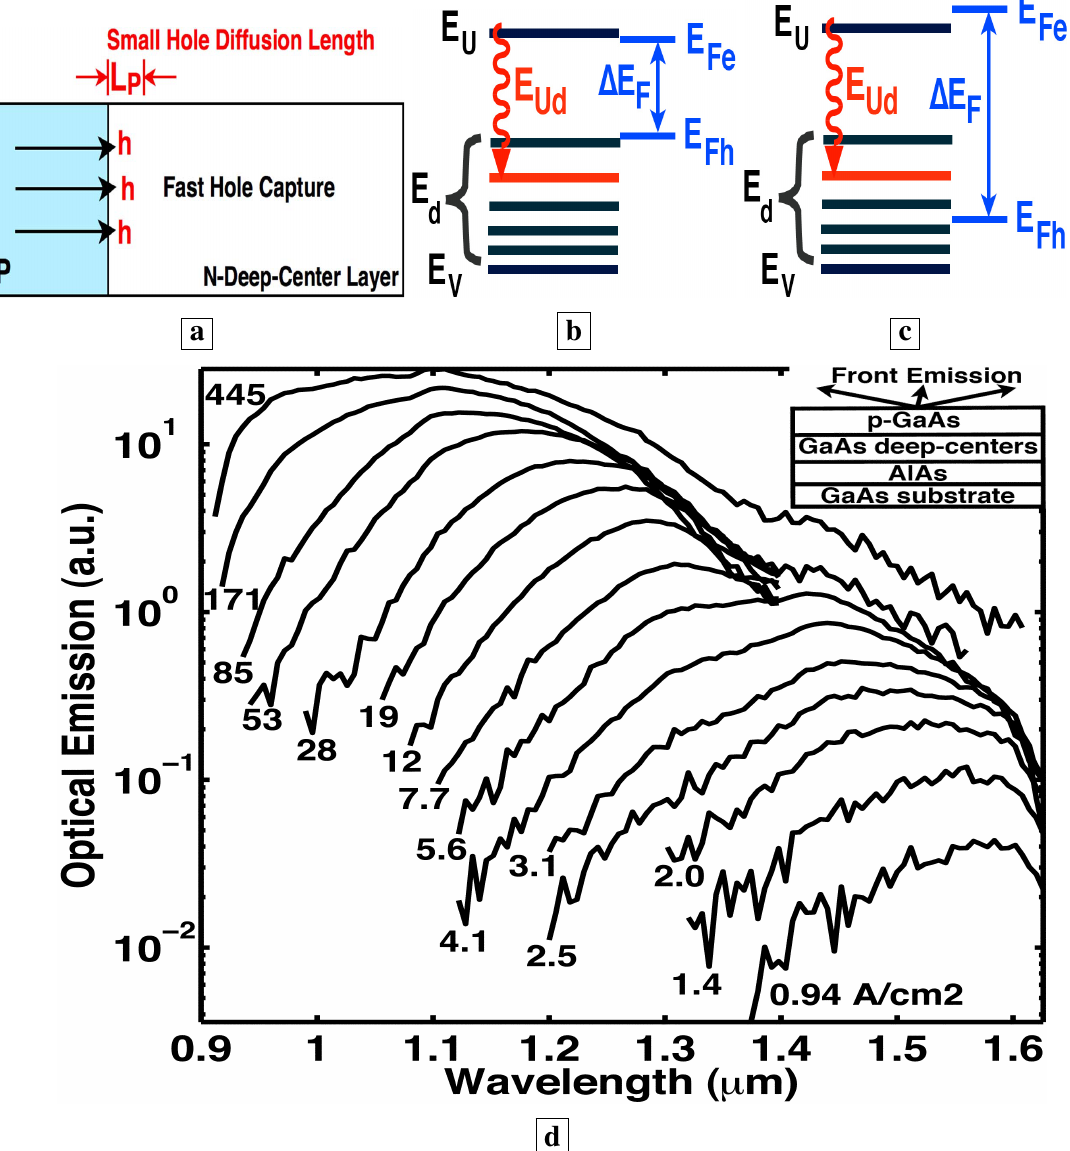
Figure 13 . Room-temperature spectra measured from the surface of Sample F [6]. a, Layer structure showing p-doped layer, n-type deep-center layer, and hole diffusion length. b, At low current, the hole quasi-Fermi level E is above midgap, and most of the optical Fh emission is at long wavelengths (1.6 µ m). At high current, E is pulled far below midgap, Fh and most of the optical emission is at shorter wavelengths (1.1 µ m). Here, ∆ E exceeds F the transition energy E . This is the Bernard-Duraffourg signature for stimulated emission Ud at E . d, Room-temperature optical-emission spectra measured from the sample surface at Ud different injection in the absence of a resonant cavity. The observed blue shift in the optical emission corresponds to a similar increase in ∆ E with increasing F